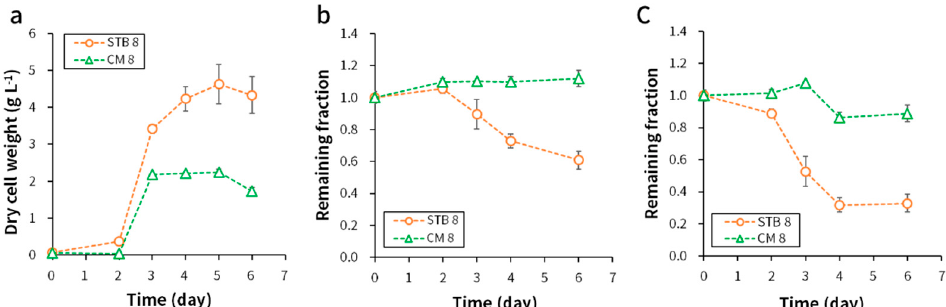
Figure 4. ( a ) Biomass production, ( b ) COD consumption, and ( c ) T-N consumption using STB and CM medium at an initial pH 8. Sample analyses were performed in duplicate, and the data were represented as average ± standard error ( n = 4).